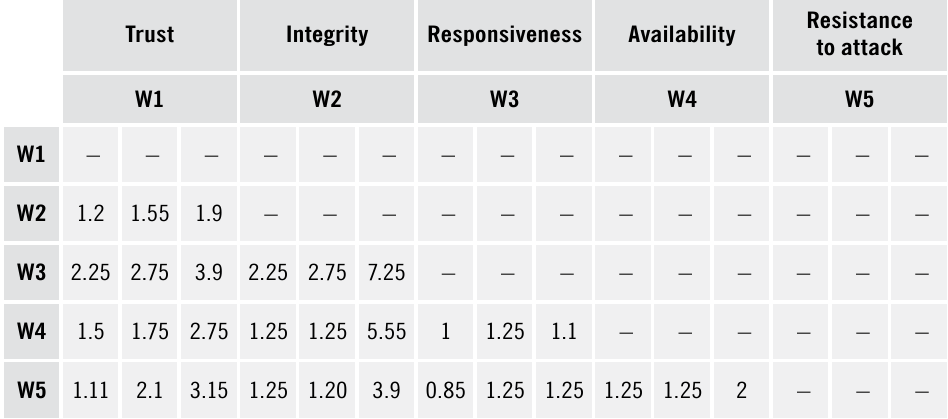
Table 3. Paired comparison matrix of security sub-criteria of reliability, based on experts opinions Trust